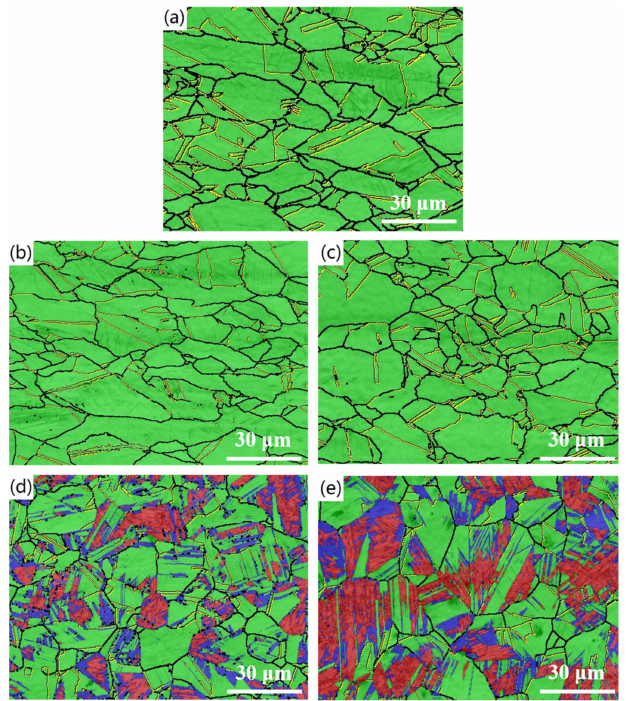
Figure 1. EBSD phase maps on band contrast of 0B steel with different annealing temperatures. ( a ) 0B-HR; ( b ) 0B-600; ( c ) 0B-700; ( d ) 0B-800; ( e ) 0B-900. Green = γ , blue = ε , red = α (cid:48) , black = unindexed areas/grain boundaries, yellow = twinning boundaries. Rolling direction = horizontal, thickness direction = vertical. Table 2. Phase fractions and AGS of the annealed samples according to EBSD.